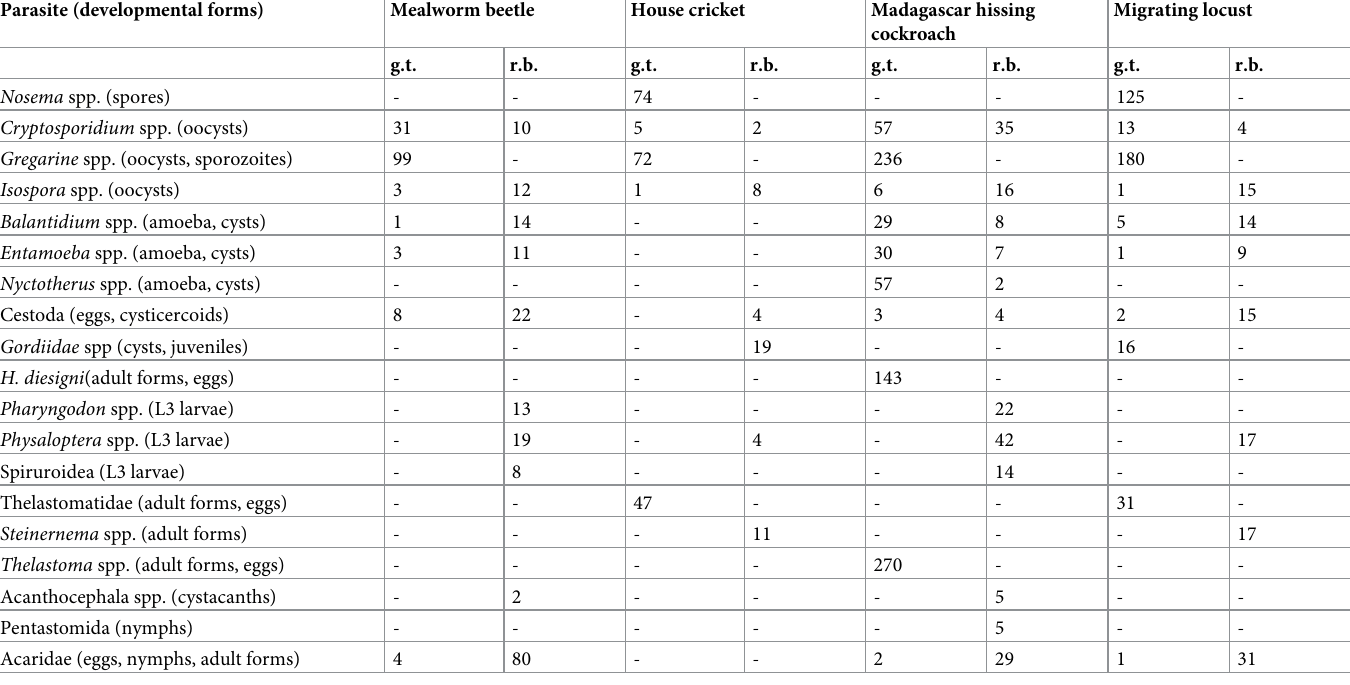
insects imported from Africa and Asia than in insects purchased from European suppliers. Table 1. Type / Species and developmental forms of parasites found in the examined insects in the examined collective / individual samples depending on the place of detection. Parasite (developmental forms) Mealworm